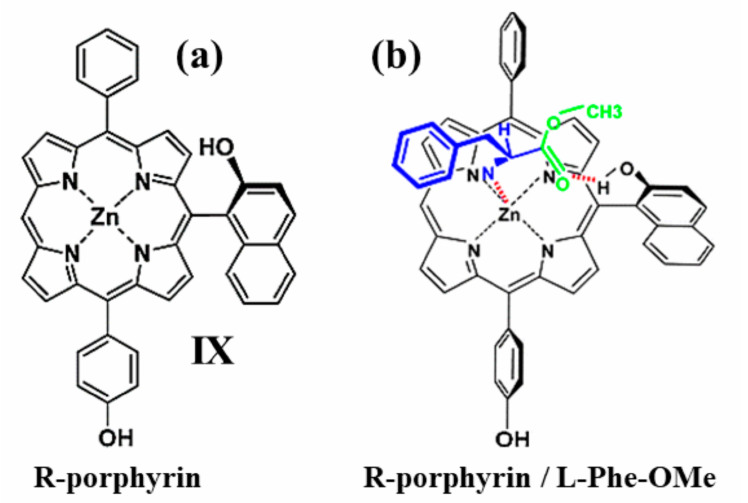
Figure 6. ( a ) Structure of the chiral Zn(II)-porphyrin IX synthesized by Yang et al.; ( b ) Interactions between R-enantiomer of the chiral porphyrin IX with L-Phe-OMe. Adapted with permission from reference [18]; published by American Chemical Society